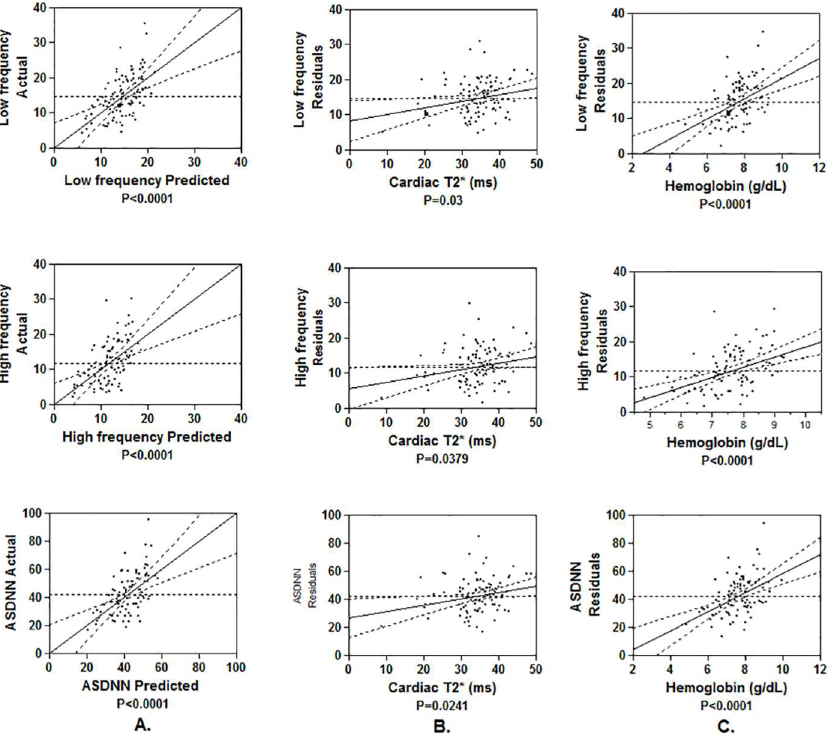
Fig 1. The scatter plots for the correlation between HRV [1) low frequency (upper row), 2) high frequency (middle row) and 3) ASDNN (lower row)] and hemoglobin and cardiac T2 * . A: whole model of multiple linear regression analysis; B: the correlation between HRV and cardiac T2 * ; C: the correlation between HRV and hemoglobin. ASDNN, the average of the standard deviationof all R-R intervals for all 5-minute segments in the 24-hour recordings.